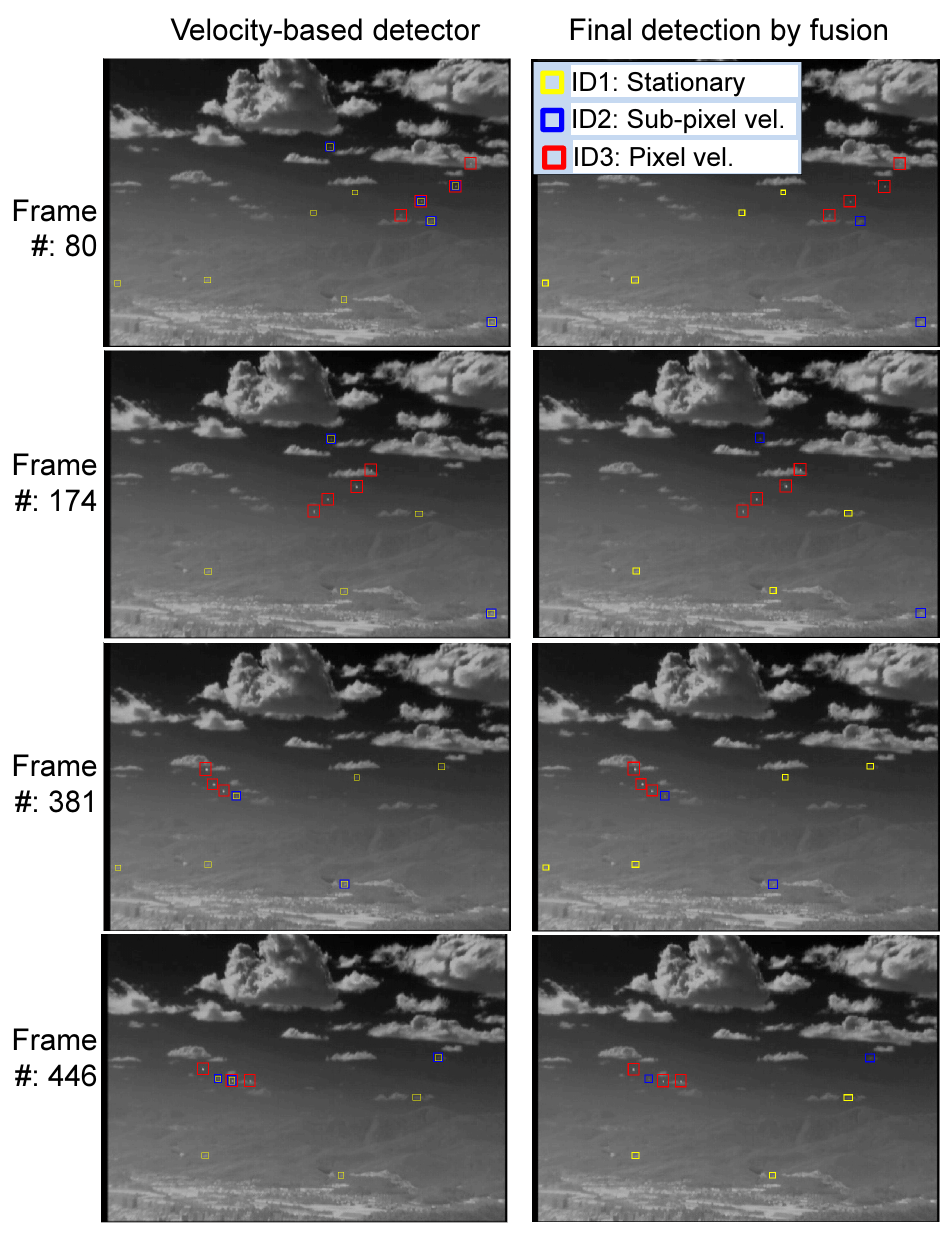
Figure 25. Effects of the proposed target detection system on the test